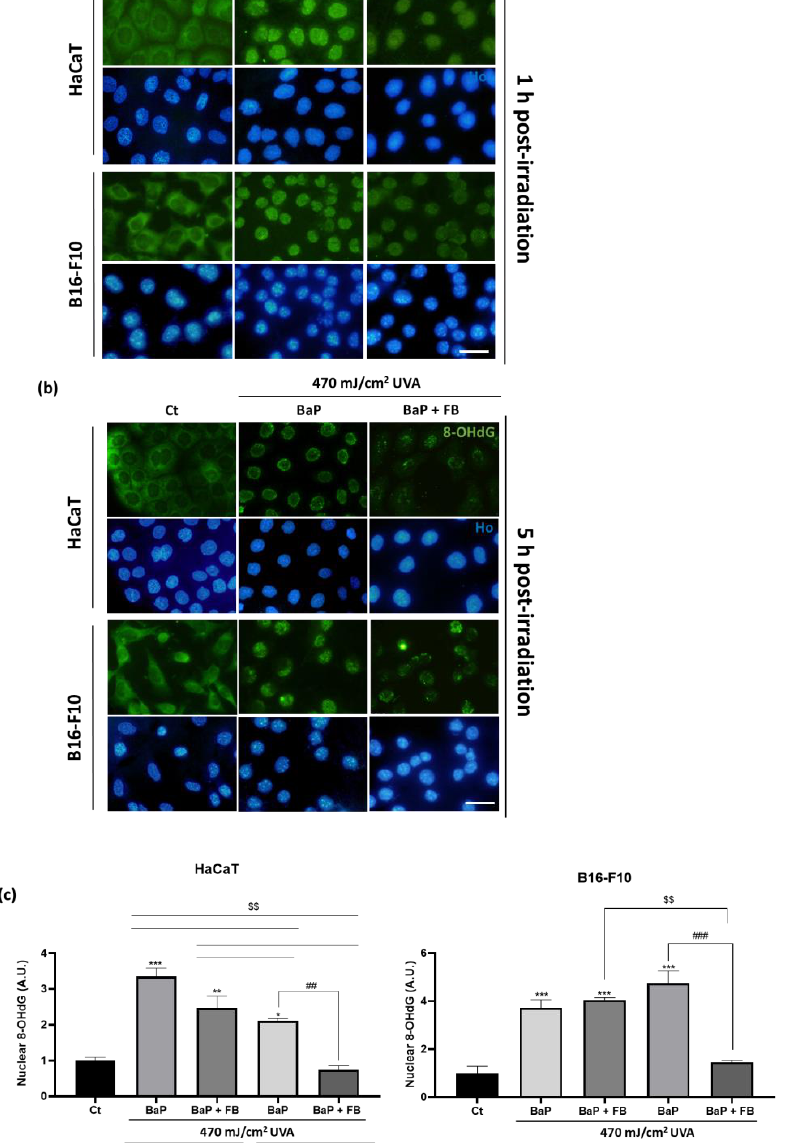
Figure 7. Localization and intensity of 8-OHdG in HaCaT and B16-F10 cells after BaP, FB and UVA light treatments. Cells incubated with BaP or BaP + FB and immediately exposed to 470 mJ/cm 2 of UVA light. 8-OHdG expression was evaluated 1 h and 5 h after light exposure. ( a ) Fluorescence microscopy images of 8-OhdG localization 1 h after irradiation. Cells treated with BaP and exposed to UVA light showed increased 8-OHdG fluorescence levels at the nuclei of the cells. Cells treated with BaP + FB and sequentially exposed to UVA light showed a dramatic reduction of nuclei accumulation. ( b ) Fluorescence microscopy images of 8-OhdG 5 h after irradiation. All treatment conditions showed a decrease in fluorescence intensity inside cell nuclei compared with that observed 1 h after the treatments. Scale bar: 20 µ m. ( c ) Quantification of 8-OhdG fluorescence intensity in both cell lines with the ImageJ Software. The results showed a significant increase in cells treated with BaP and exposed to UVA light in both 1 h and 5 h after irradiation. Moreover, intensity levels in cells treated with BaP + FB and UVA light were also significantly higher when compared to the control, but significantly slower when compared to BaP combined with UVA light 1 h after irradiation. 5 h